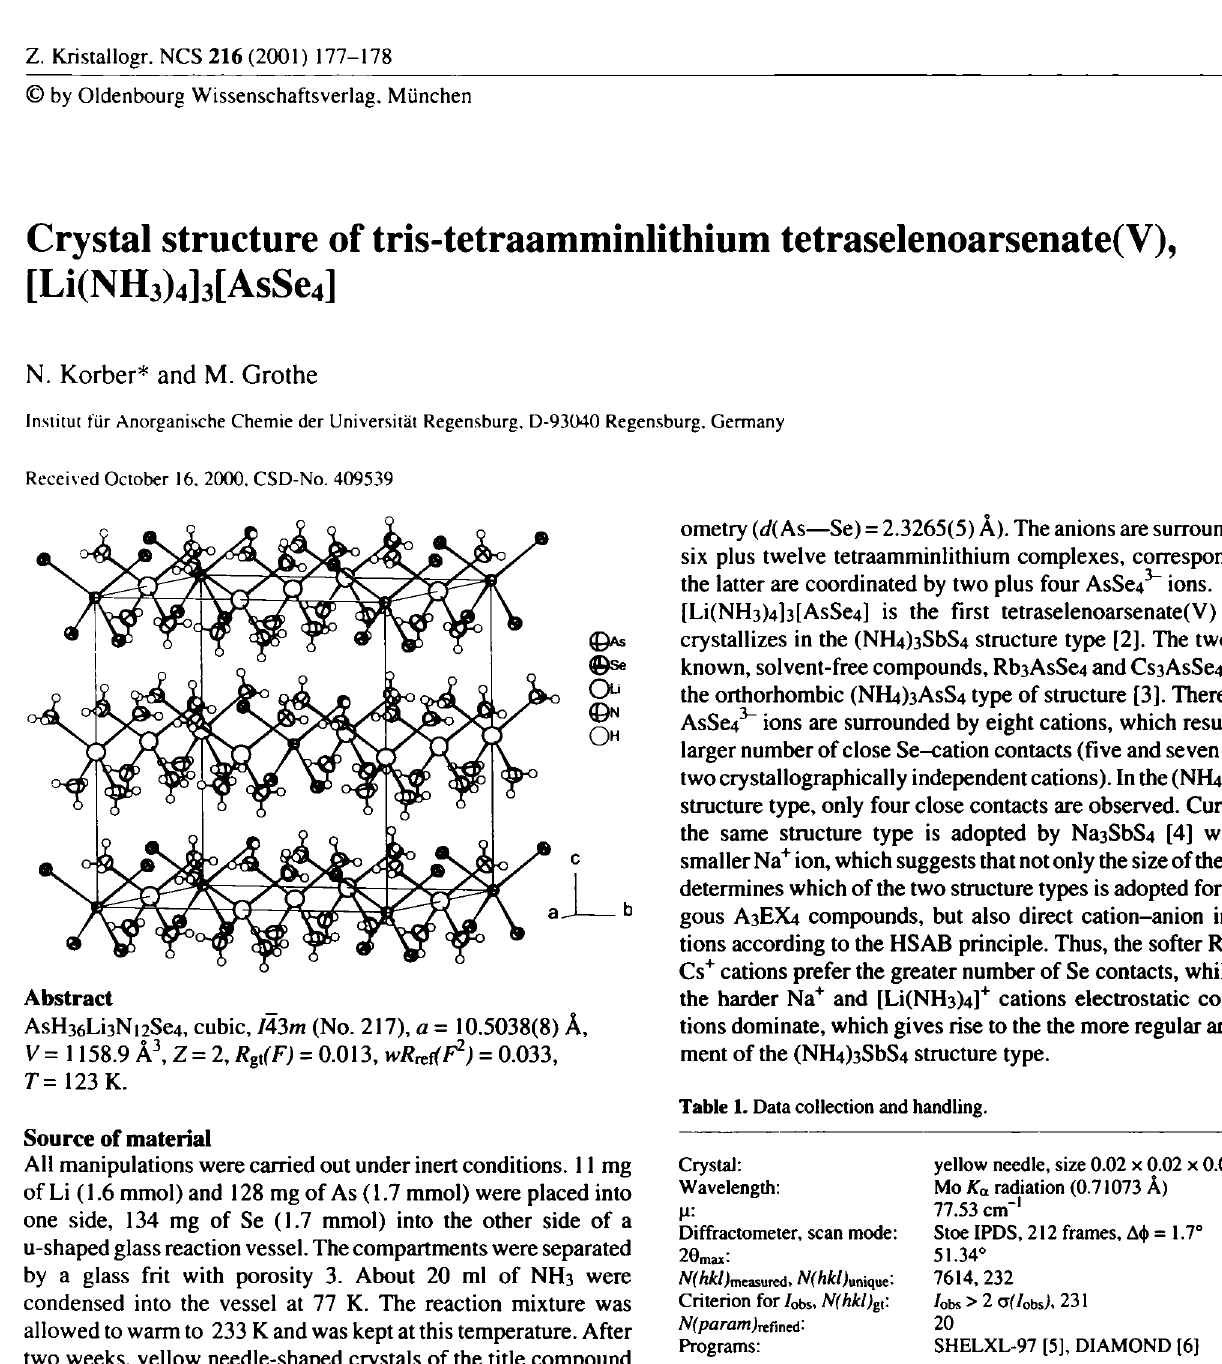
Table 2. Atomic coordinates and displacement parameters (in Ä 2